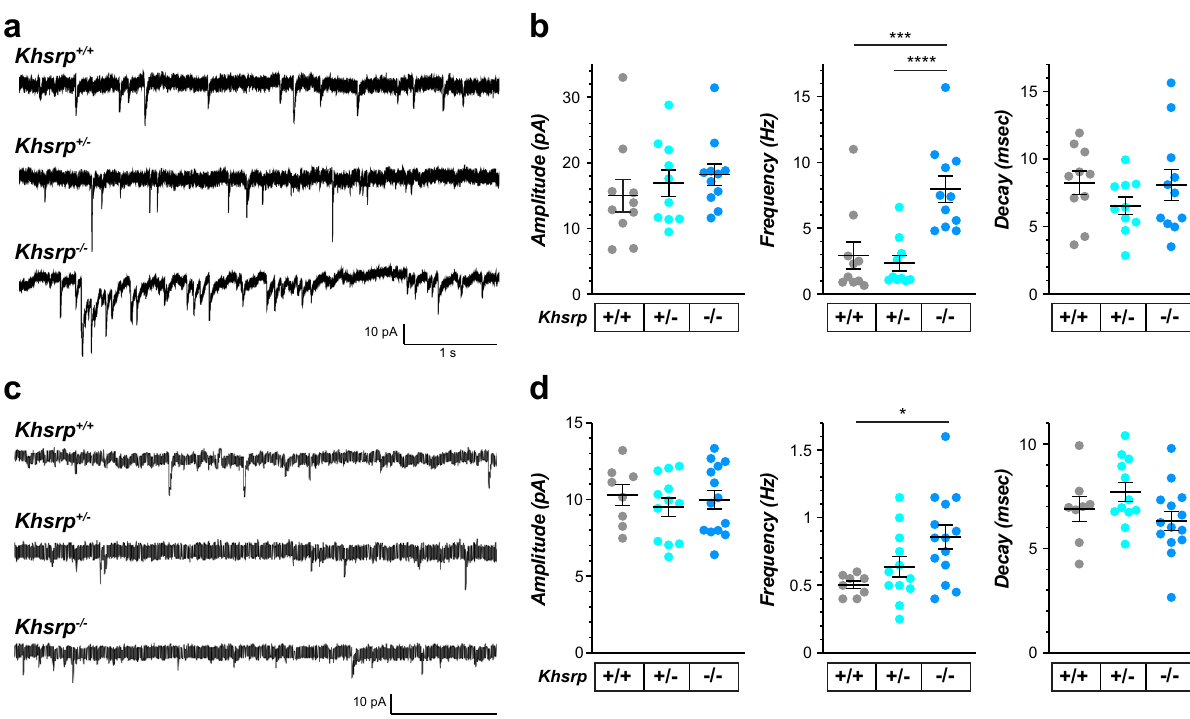
Fig. 5 Increased pre-synaptic activity in KHSRP de fi cient mice. a Representative traces of AMPA receptor-mediated miniature excitatory post-synaptic currents (mEPSCs) in CA3 pyramidal neurons of the dorsal hippocampus. b mEPSC frequency is signi fi cantly increased in Khsrp − / − relative to Khsrp + / + and Khsrp + / − hippocampus. There were no signi fi cant differences in mEPSC amplitude or duration (decay time) between genotypes ( N = 10 Khsrp + / + , 10 Khsrp + / − , and 11 Khsrp − / − over 5 animals per genotype; frequency data analyzed by one-way ANOVA, F(2,28) = 11.97, p = 0.0002; *** p ≤ 0.01 and **** p ≤ 0.001 by Tukey ’ s post-hoc comparisons). c Representative traces of AMPA receptor-mediated mEPSCs in layer 5 pyramidal neurons of the infralimbic cortex. d Infralimbic cortical neurons show increased mEPSC frequency in the Khsrp − / − relative to Khsrp + / + mice. As in the CA3, no differences in mEPSC amplitude or duration were detected ( N = 8 Khsrp + / + , 12 Khsrp + / − , and 14 Khsrp − / − over 5 animals per genotype; frequency data analyzed by one-way ANOVA, F (2,31) = 5.03, p = 0.013; * p ≤ 0.05 by Tukey ’ s post-hoc